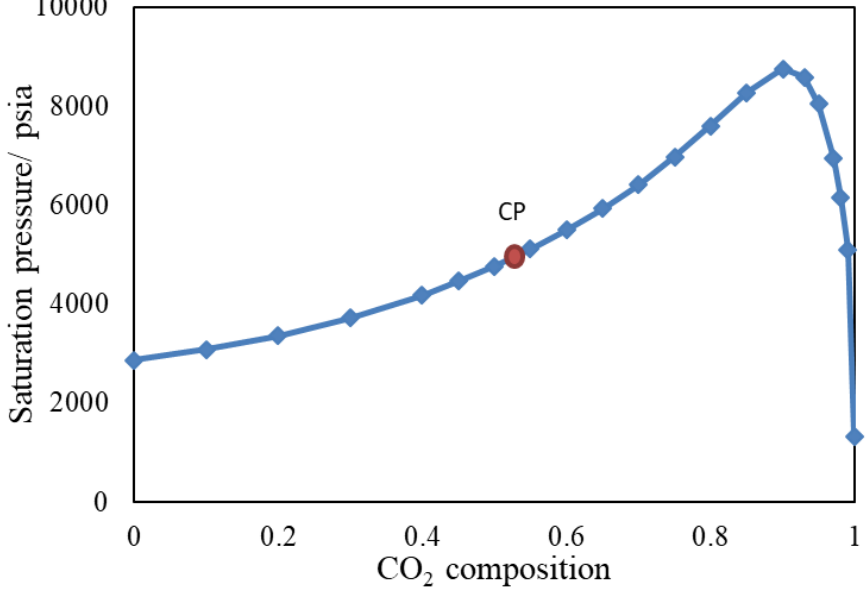
Figure 20. Swelling test for Bakken-CO 2 fluid.